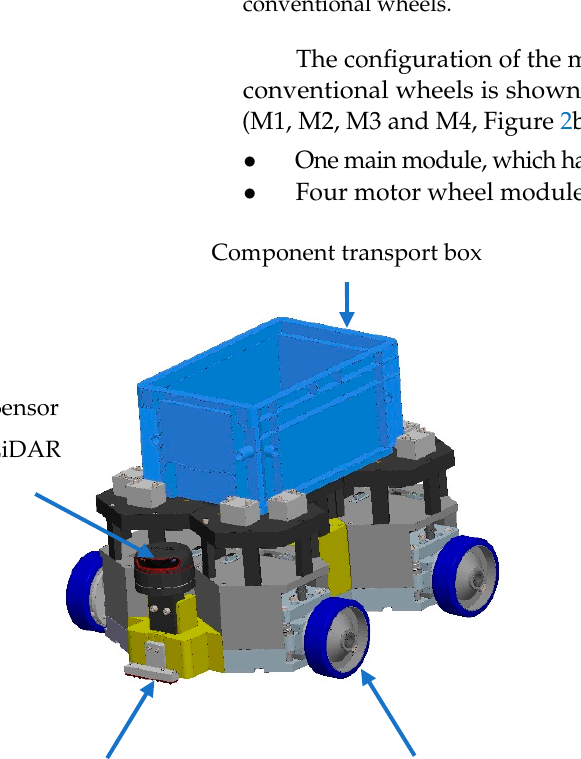
Figure 1. Possible con fi gurations of the modular mobile platform. ( a ) Mobile robot with two con- ventional wheels. ( b ) Mobile robot with three omnidirectional wheels. ( c ) Mobile robot with four conventional wheels.